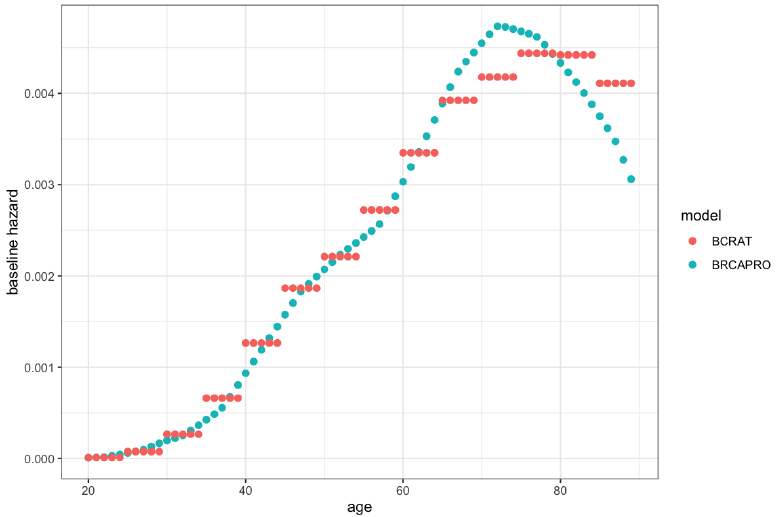
Figure A1. BCRAT cause-specific hazard of breast cancer for White women in the general population (˜ λ ( t ) = ˜ λ ( t ) / ( 1 − AR ( t )) ) and BRCAPRO cause-specific hazard of breast cancer for White female B B , 0 ( t ) non-carriers ( λ 0 B